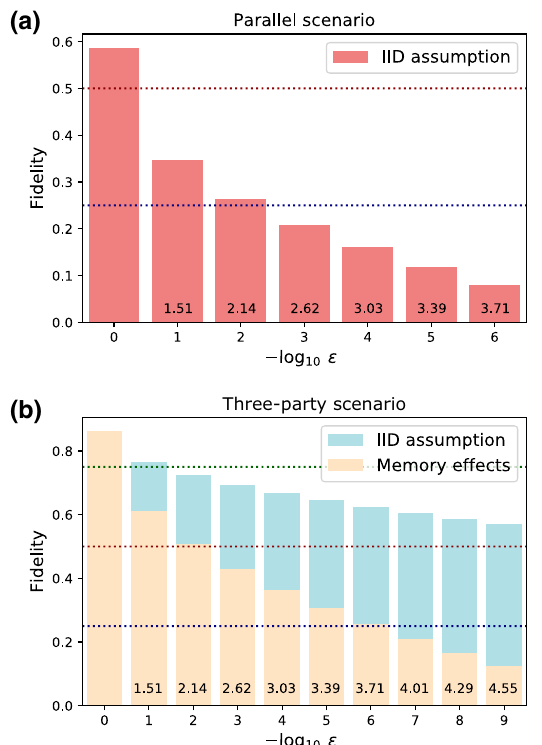
FIG. 4. Certifiable fidelities and device-independent confi- dence levels. We show the lower bounds on the certifiable fidelities in both of the scenarios studied as a function of the probability (cid:12) that for all configurations j , f j / ∈ { P j − t j ((cid:12)) , P j + t j ((cid:12)) } , where f j are the observed frequencies, P j